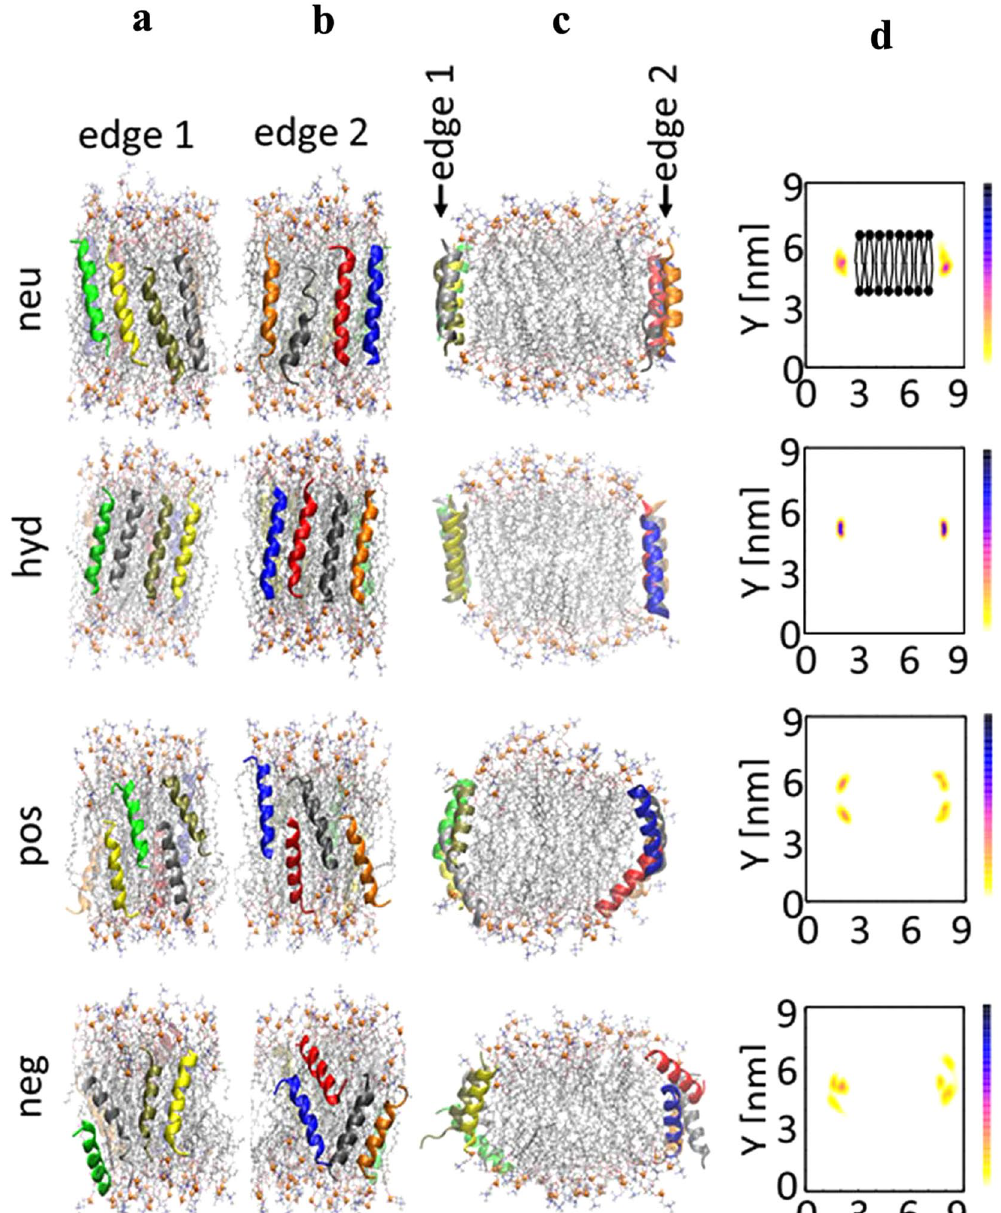
Figure 7. Four edge-bound simulations with 60:6:8 POPC:chol:peptide (Set 3, high density). Each system includes eight identical peptides located on two edges of a bilayer slab antiparallel to each other. ( a – c ) Side views at 500 ns. Side view along the bilayer periodicity is shown in ( c ). Peptides, colored ribbons; POPC, sticks; phosphorus of POPC, orange balls; cholesterols, black sticks. Schematic top-down view is shown in Fig. 6. ( d ) Number-density maps of C α of 9 th residue of peptides viewed along the direction of bilayer periodicity. Bilayer is shown schematically in the top